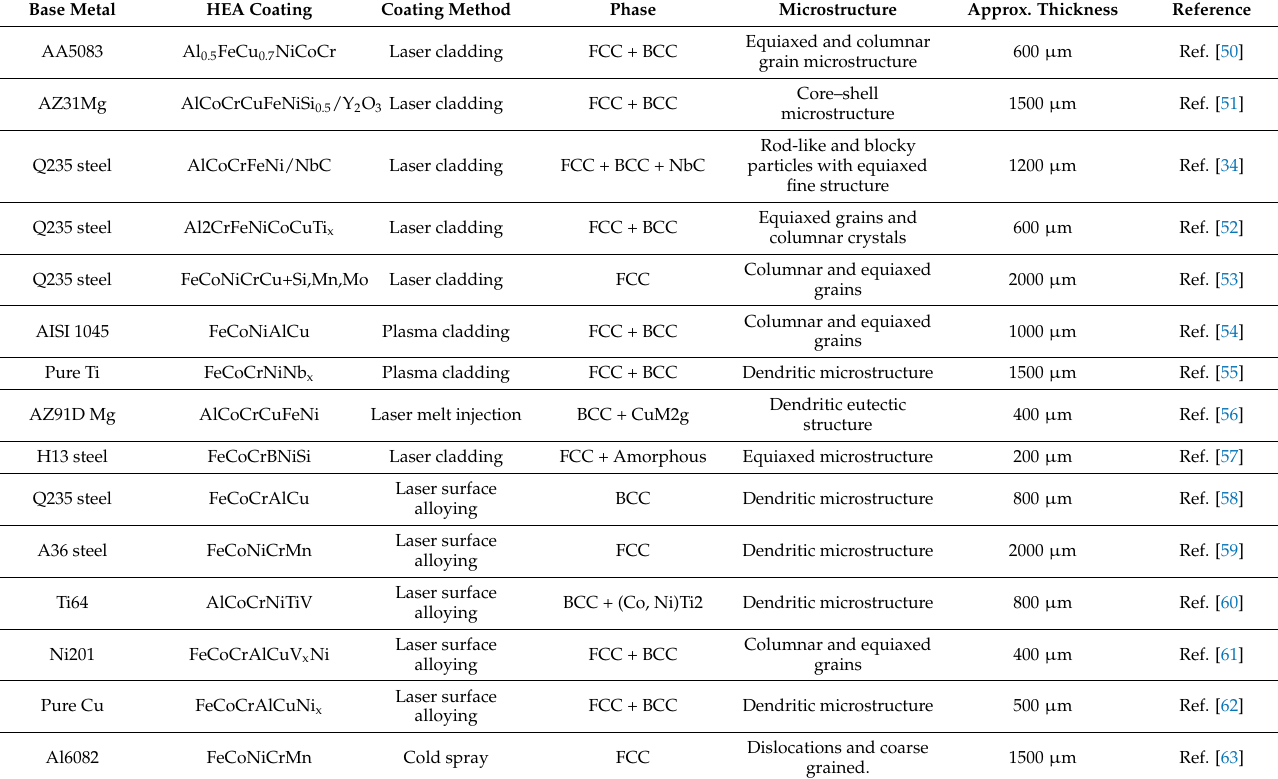
Table 1. The details about HEA-related coatings fabricated by various coating